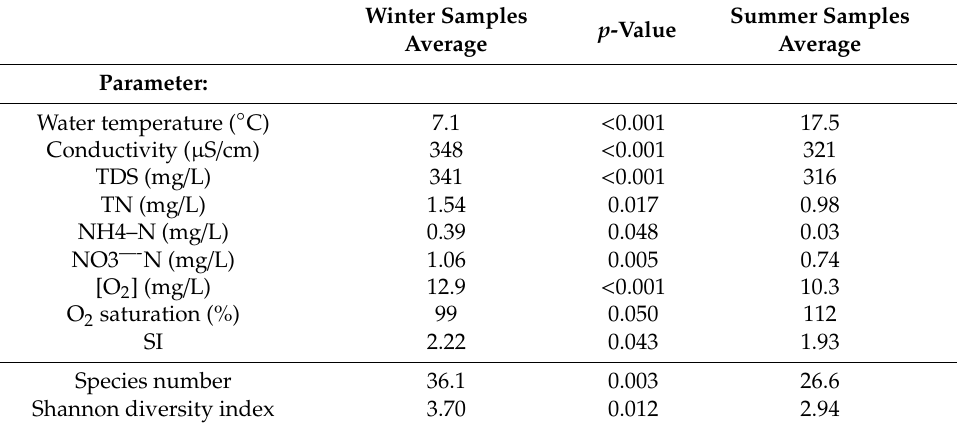
Table 2. Average values of winter and summer samples for the parameters and indices that were statistically significant according to t -test.